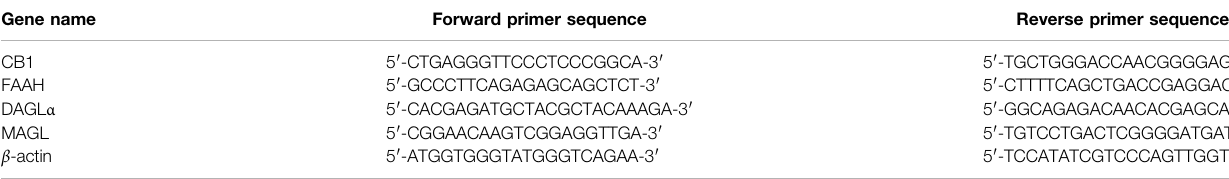
TABLE 1 | Primer information for the real-time PCR